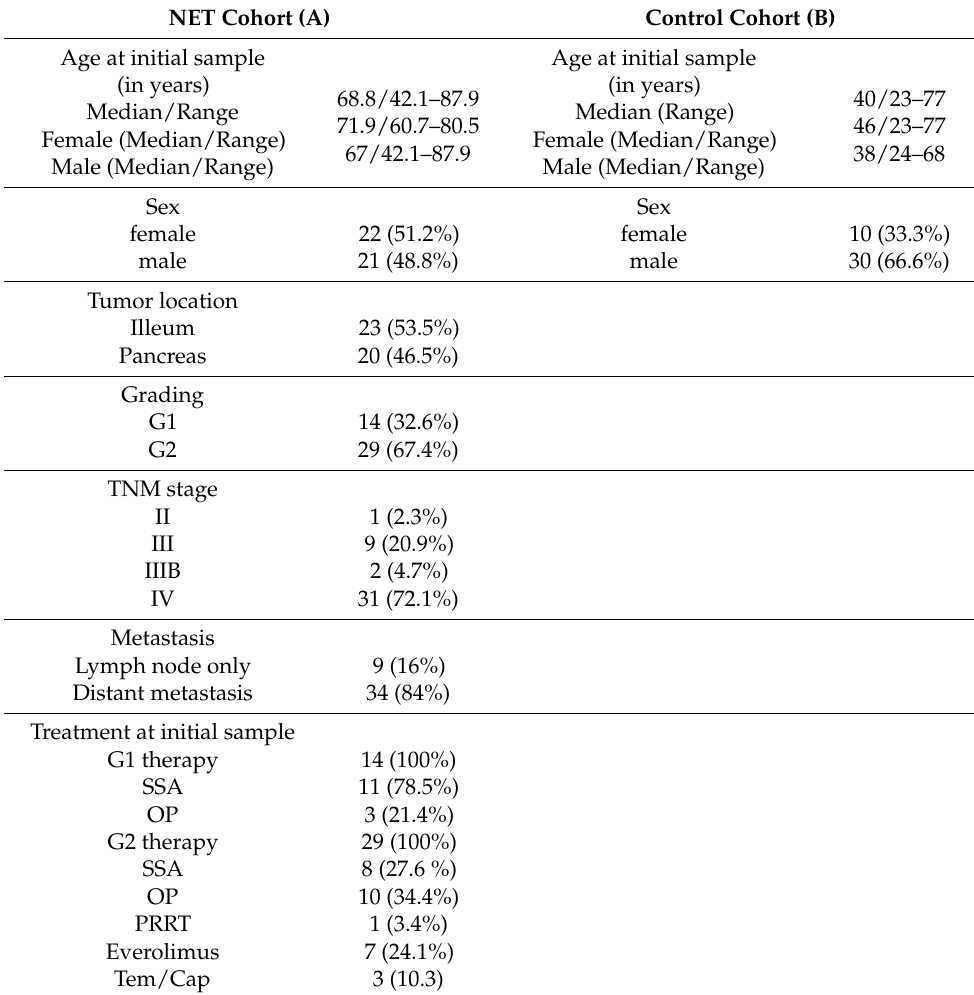
Table 1. Patient and control characteristics. If not indicated otherwise, data are shown as n (%) of patients or median and range. Percentages were rounded and may not sum to 100%. Table includes ( A ) patients with NETs of gastroenteropancreatic origin and ( B ) healthy